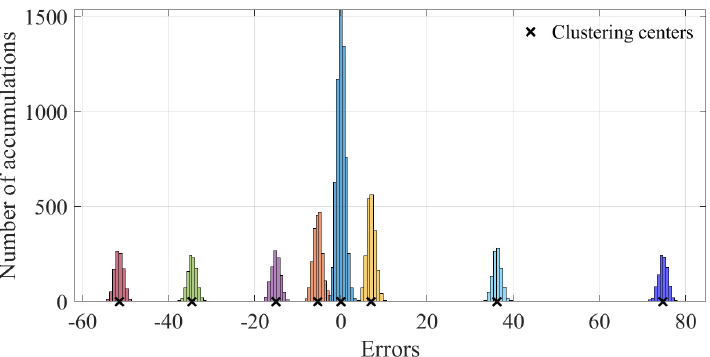
Figure 15. Clustering results of the k-means++